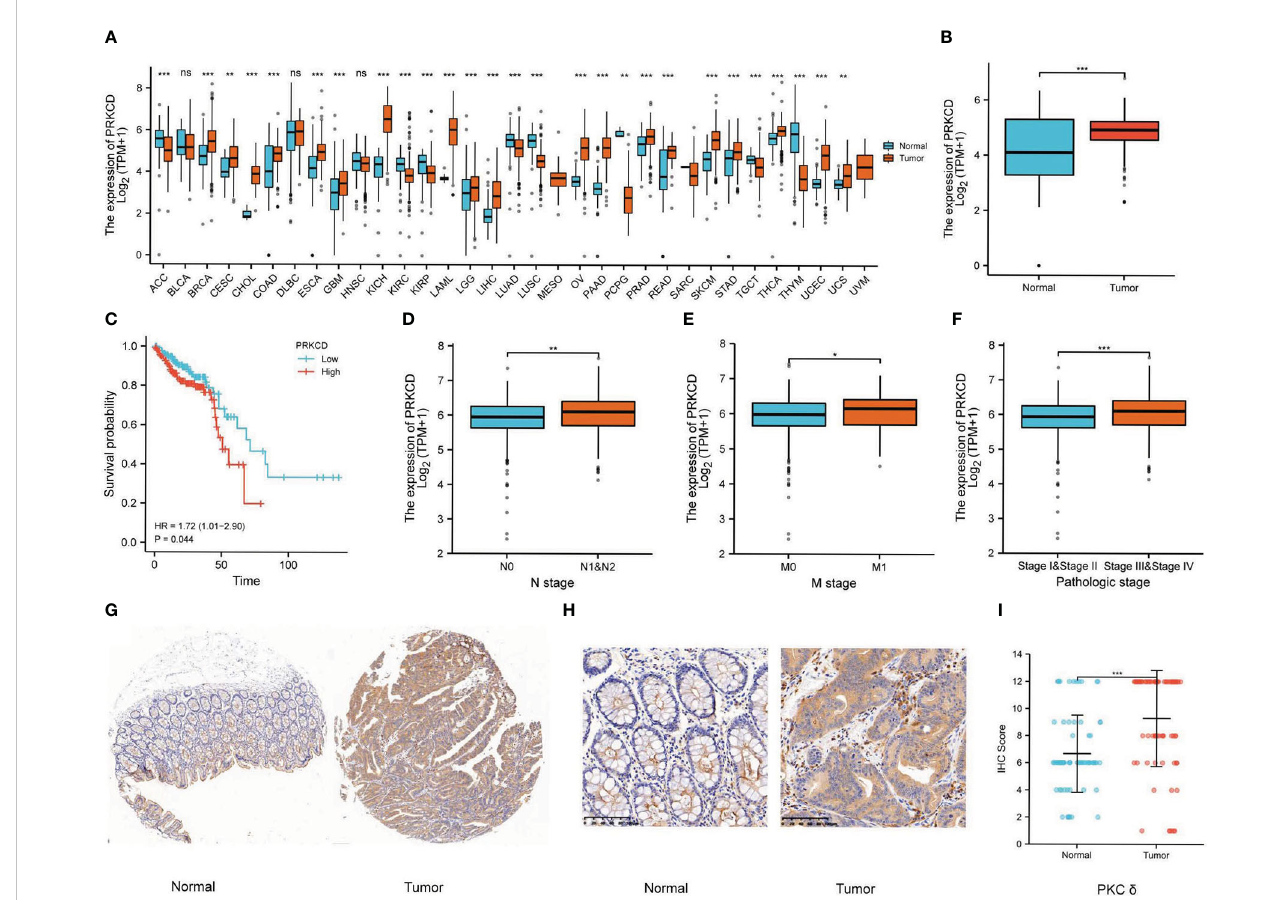
FIGURE 1 PKC d is overexpressed in tumor tissues and related to poor prognosis in CRC. (A) The expression of PKC d in pan-cancer and (B) CRC in the GTEx and TCGA database. The relationship between PKC d and (C) the prognosis, (D) lymph node metastasis, (E) distant metastasis, and (F) tumor stage of CRC in the TCGA database. (G-H) The expression of PKC d in CRC was detected by IHC. (I) Analysis of IHC results in 73 pairs of CRC tumor tissue and normal tissue by ggplot2. *p < 0.05, **p < 0.01, ***p < 0.001. ns, no signi fi